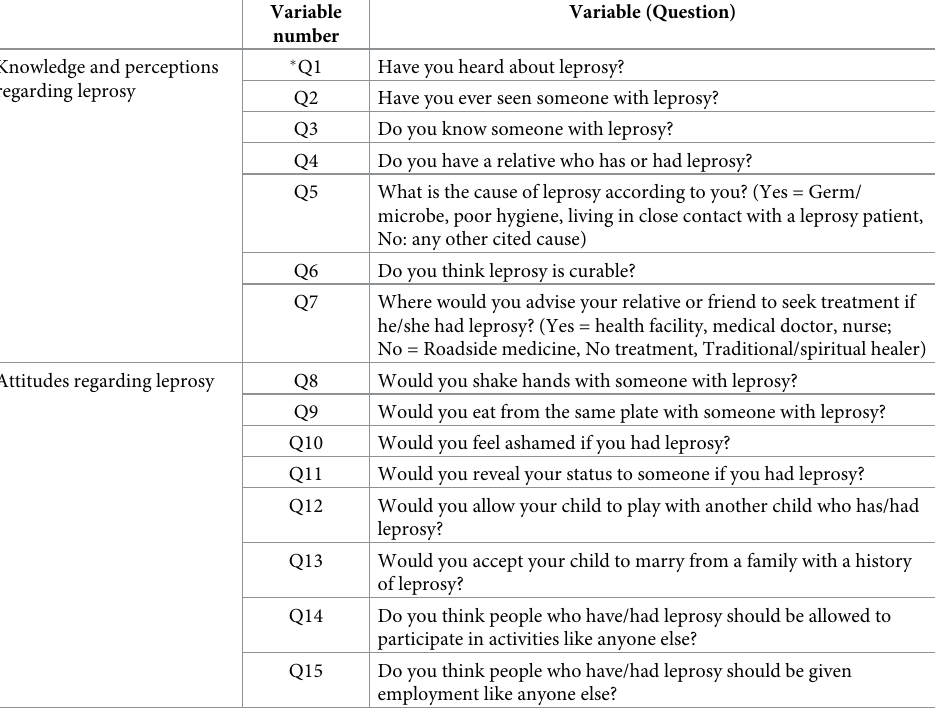
Table 1. List of study outcome variables.